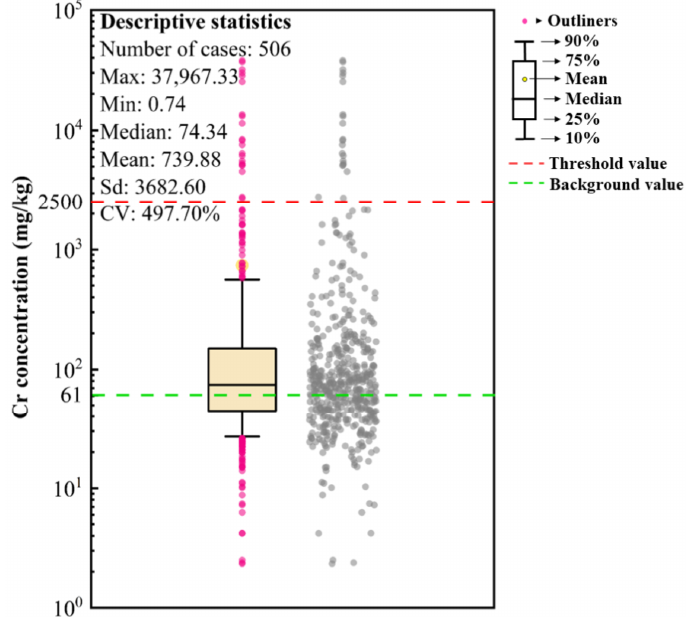
Figure 1. The boxplot and the descriptive statistics of the soil Cr concentrations in industrial regions across China.